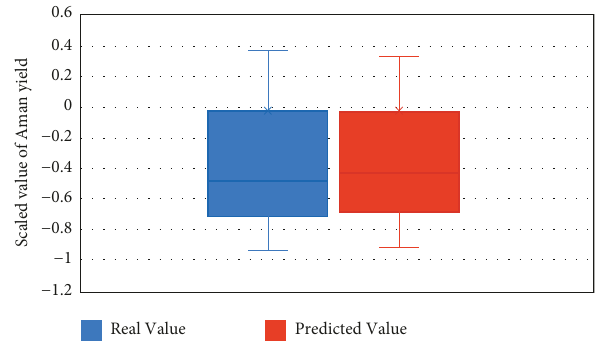
Figure 17: Comparison between real values and predicted values of Aman yield for XGBoost using box